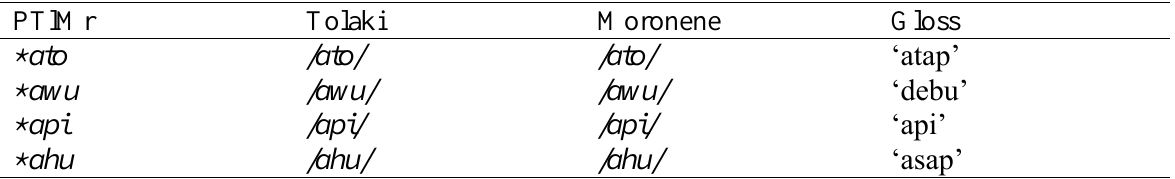
Tabel 1. The intial position of the word